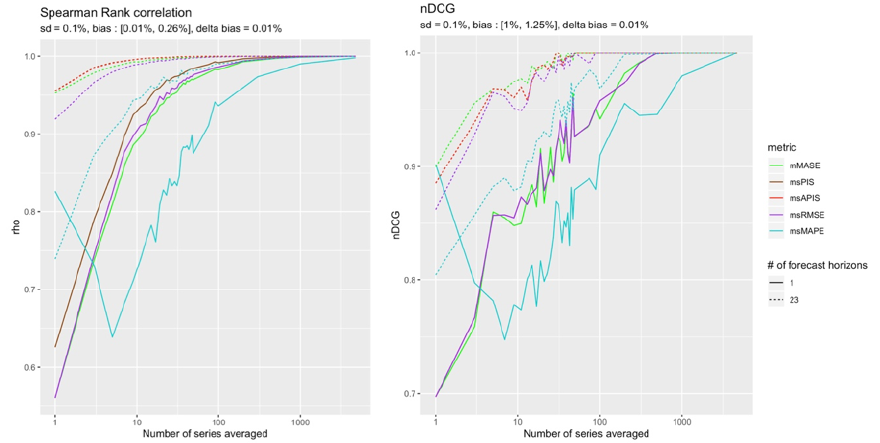
Figure 20. Spearman Rank correlation and nDCG for ( − − − ) configuration.